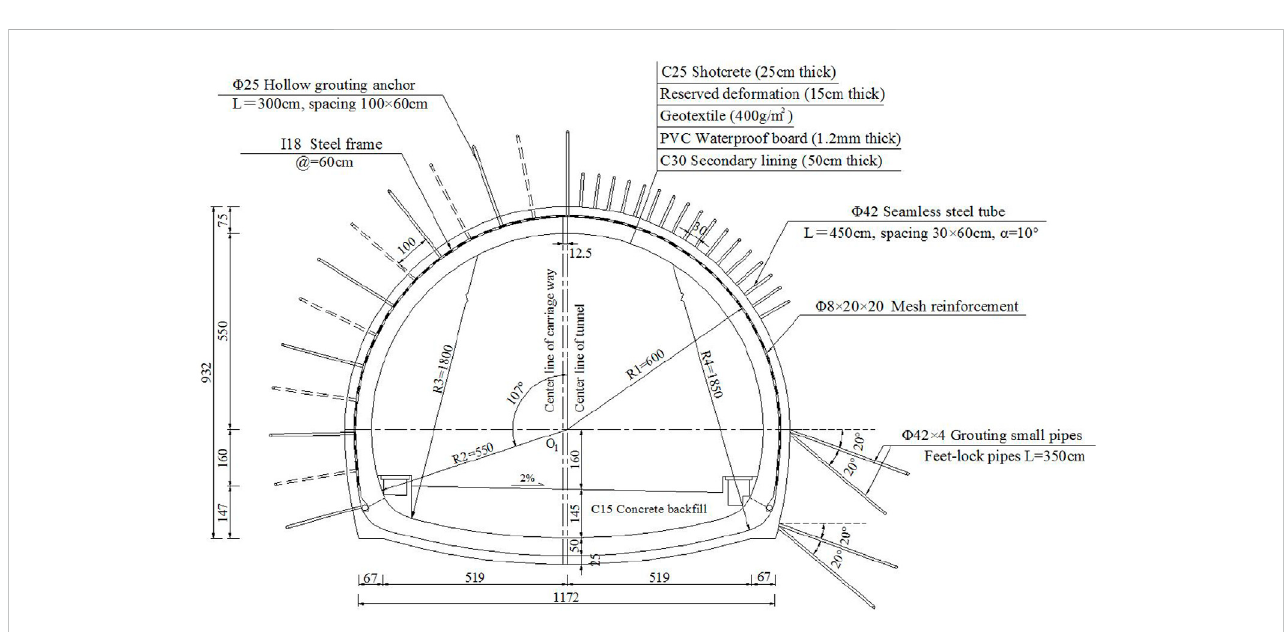
FIGURE 4 Supporting system of the tunnel mined section (units: